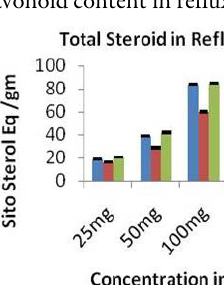
Fig. 9. Total steroid content in reflux